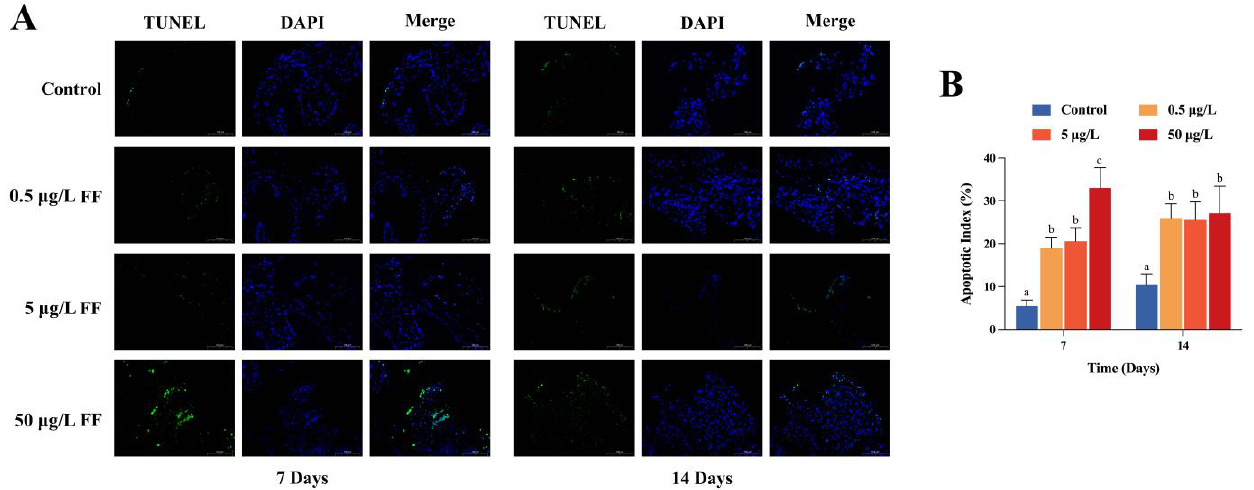
Figure 2. Effects of FF-exposure on apoptosis characteristics in Chinese mitten crab intestine. ( A ) Representative images in four groups. Nuclei of cell (blue) were depicted by DAPI staining, and potentially apoptotic cells (green) were indicated by TUNEL staining. Magnification is 200× and the scale bar is 100 μm . ( B ) Apoptosis index. Microscope fields were used to count total numbers of nuclei and TUNEL-positive cells, and the ratio was calculated. All data are expressed as mean ± SEM (n = 6). The different lowercase letters above each bar represent significant difference ( p < 0.05).